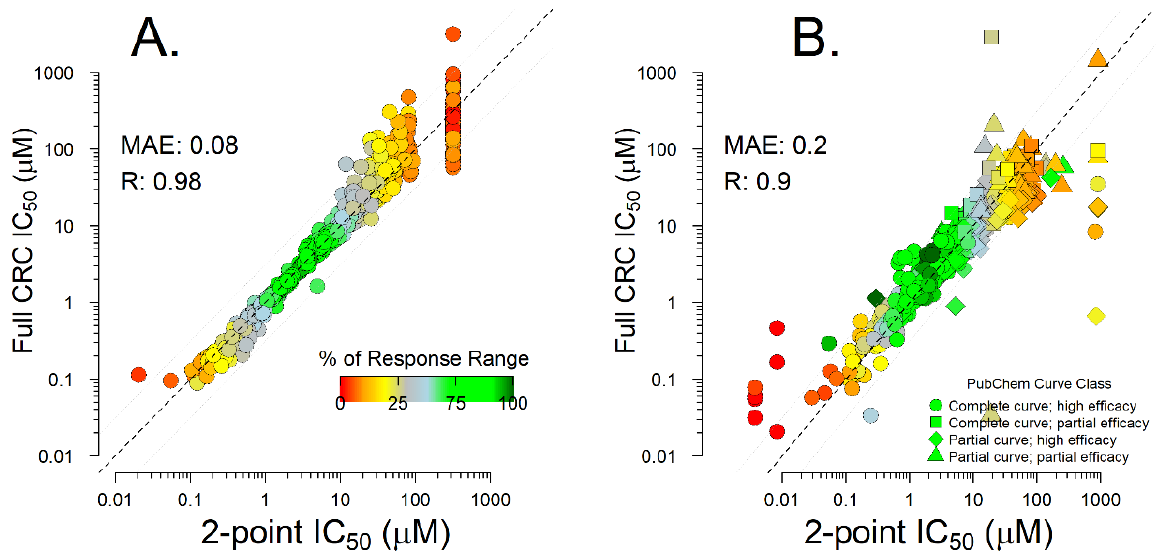
Figure 1. Correlation between IC 50 estimates derived from full dose–response curves and two-point subsets of the same dose–response curves for in-house patch clamp data ( A ) and PubChem thallium flux assay data ( B ).